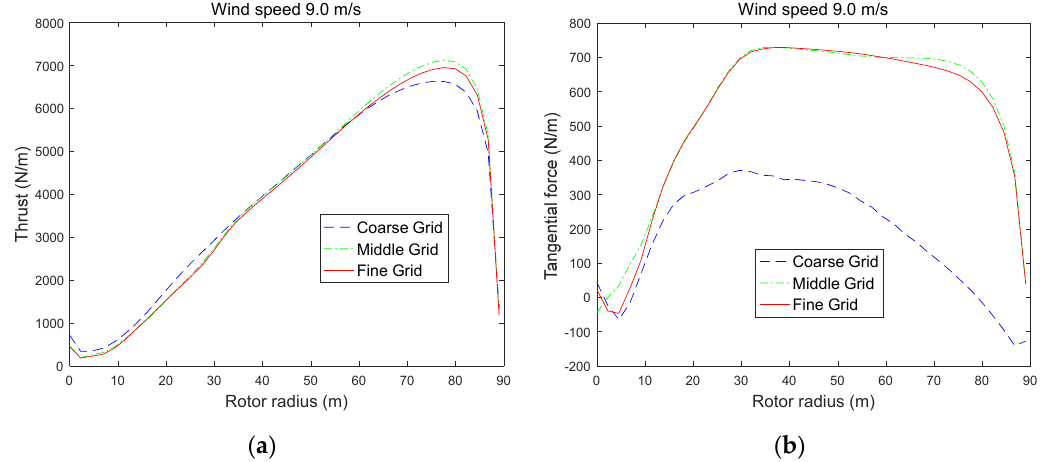
Figure 5. Performances of grid independency study: ( a ) thrust force; ( b ) tangential force. Table 2. Operational parameters of the DTU 10MW RWT rotor.